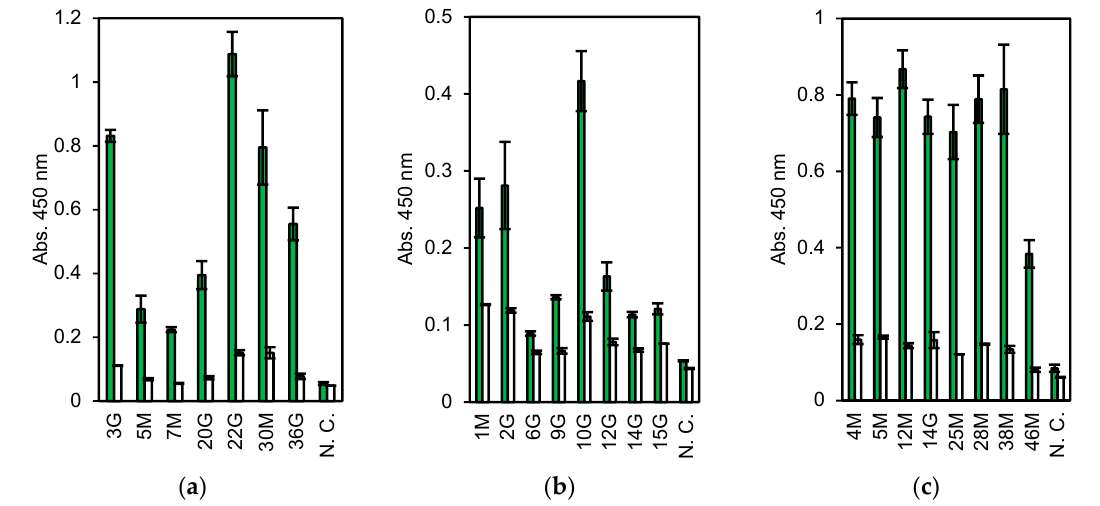
Figure 2. Enzyme-linked immunosorbent assay (ELISA) results of the cell-free products. Antigens are ( a ) Vibrio parahaemolyticus . ( b ) Escherichia coli O26, and ( c ) nontoxic VT2. Green: Antigen, White: Bovine serum albumin (BSA). N. C. means no DNA templates in the cell-free protein synthesis (CFPS) reaction. Error bars indicate standard deviations.